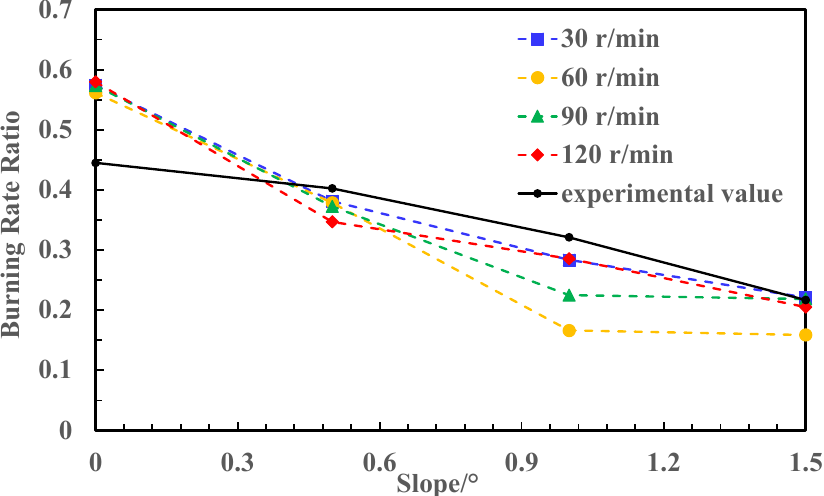
Figure 10. Variation of the burning rate ratio of spill fires with the slope.